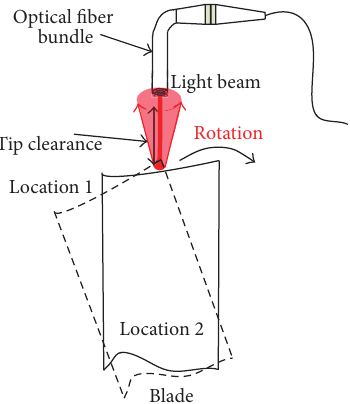
Figure 13: The front view when the blade passes through the probe.